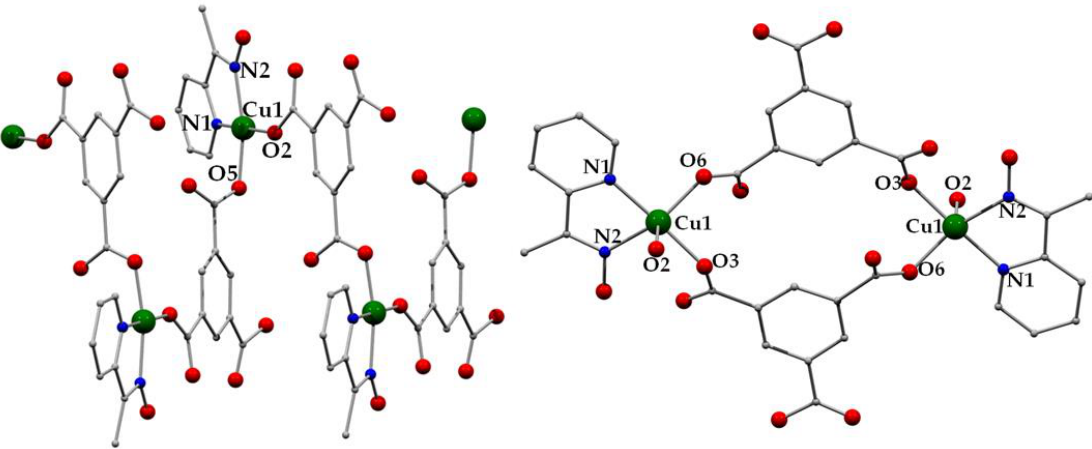
Figure 5. Left: representation of a part of the zig-zag chain in 4 . Right: representation of the molecular structure of 5 . Colour code: Cu II , green; N, navy blue; O, red; C, grey. The hydrogens are omitted for clarity.